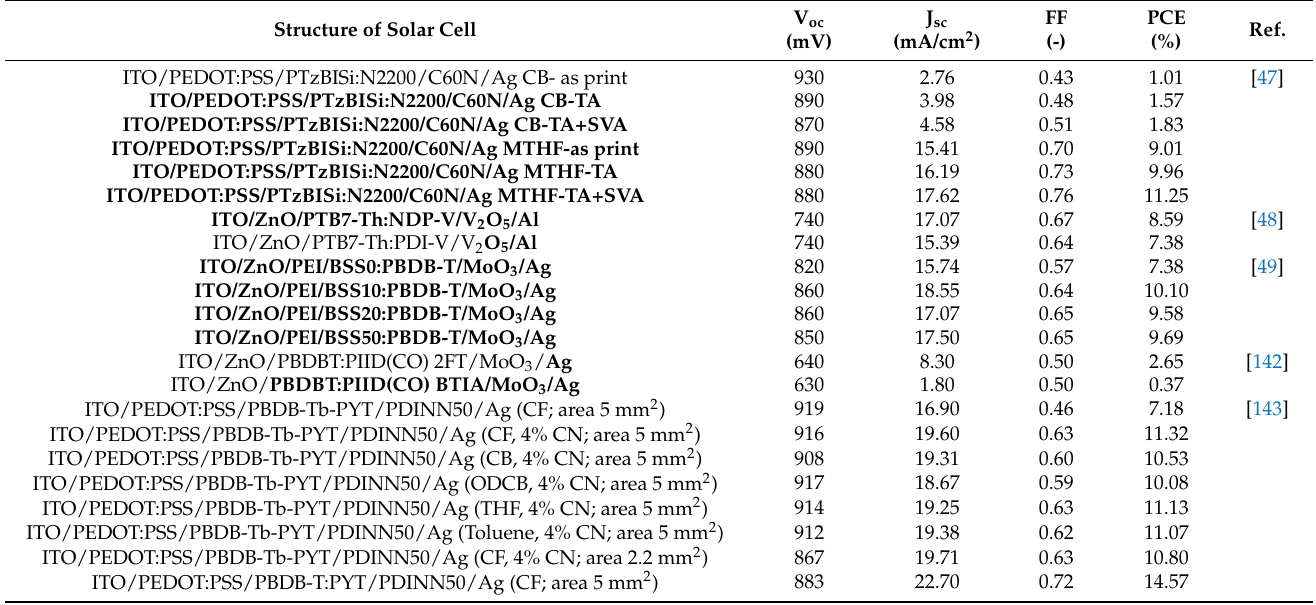
Table 8. Polymers used as an acceptor material in bulk-heterojunction solar cells. Structure of Solar Cell